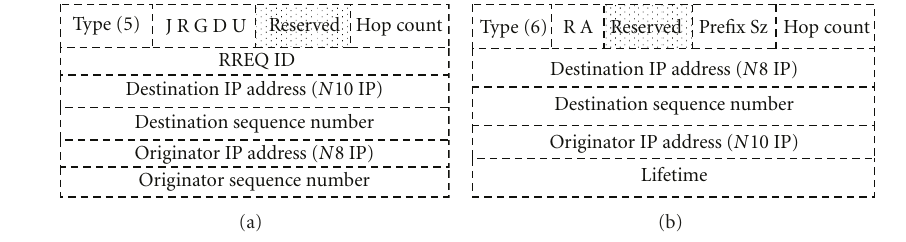
Figure 3: RREQ towards N 10 and RREP towards N 8.